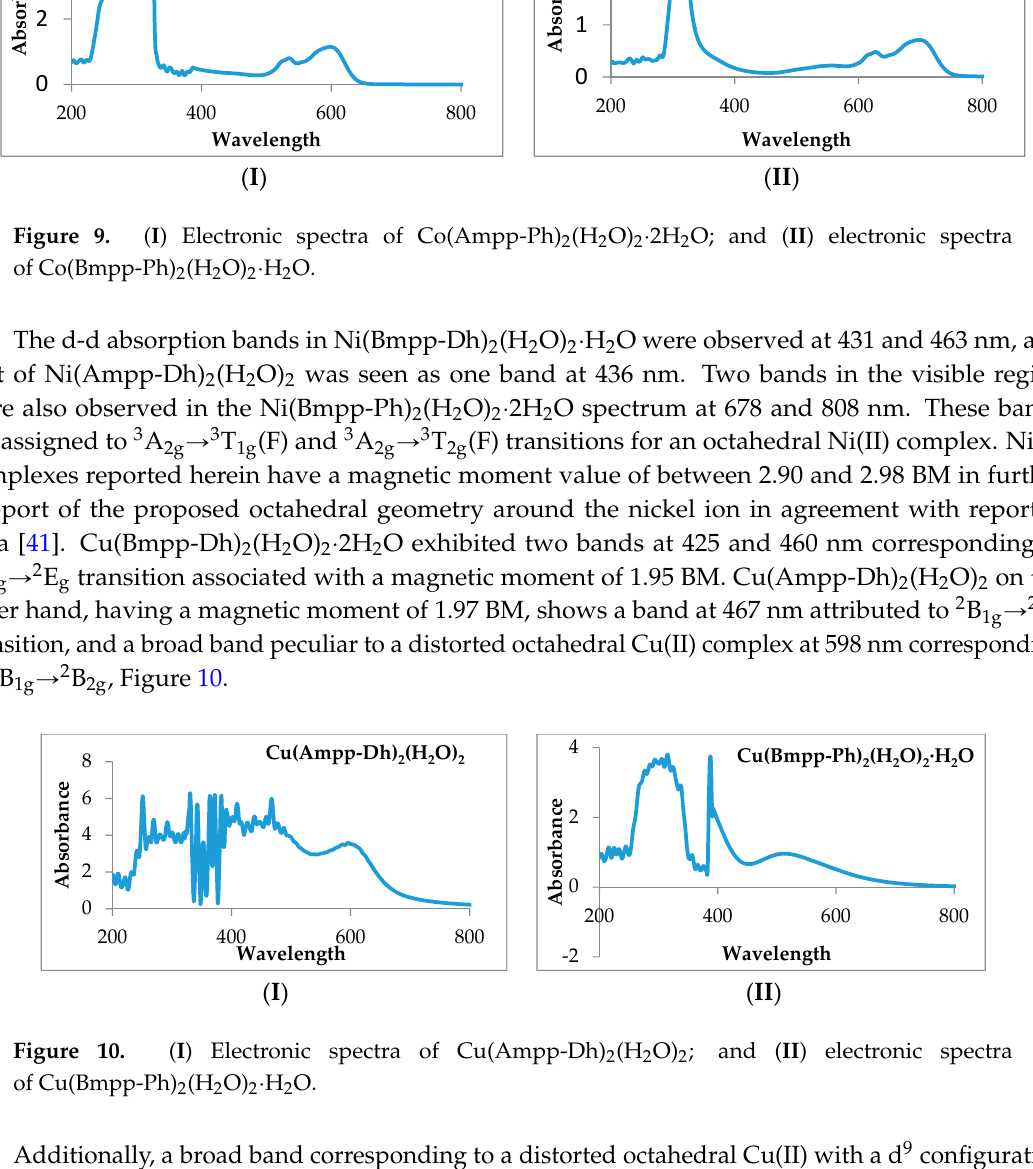
Cu(Bmpp-Ph) 2 (H 2 O) 2 ∙ H 2 O spectrum (Figure 10) and the same transition is seen as a weak, but broad, band at 594 nm for Cu(Ampp-Ph) 2 (H 2 O) 2 [41]. Cu(Bmpp-Ph) 2 (H 2 O) 2 ∙ H 2 O had a magnetic moment of 1.94 BM and Cu(Ampp-Ph) 2 (H 2 O) 2 , a magnetic moment of 1.93 BM which corroborates the d 9 octahedral Cu(II) complex proposed [39].